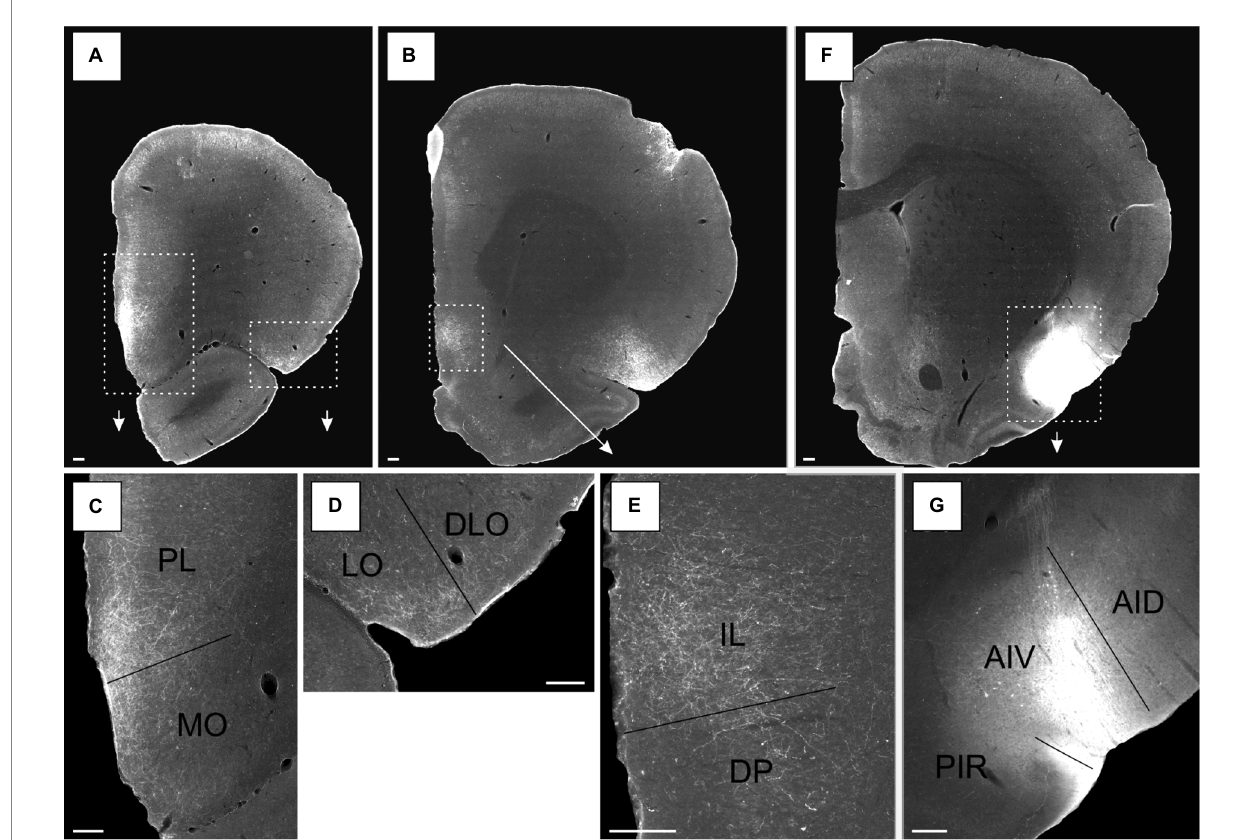
FIGURE 7 Images of the labeled projections resulting from a PHA-L injection covering all layers of the ventral agranular insular field (AIV) in the posterior insular cortex (case 13256P). (A,B) Low magnification photomicrographs of sections with fiber labeling in medial prefrontal and orbitofrontal cortices. Stippled white boxes indicate the areas with higher magnification images in C–E , associated arrows points towards the associated zoom photomicrographs. (C) Labeled fibers target superficial layers in a continuous band covering both the prelimbic cortex (PL) and medial orbital field (MO). (D) Moderate fiber labeling is distributed in the superficial layers of the lateral orbital field (LO) with substantially fewer fibers in the dorsolateral orbital field (DLO). (E) Dense labeling in the infralimbic cortex (IL), predominantly in the superficial layers, with substantial less fiber labeling in the dorsal peduncular cortex (DP). (F) Low magnification image of the position of the PHA-L tracer deposit in the AIV field. White stippled box and the arrow indicate the portion of the section highlighted in a higher resolution image in G. (G) The center of the injection site. Additional abbreviations: AID, dorsal agranular insular field; PIR, piriform cortex. Scale bars equal 200 μ